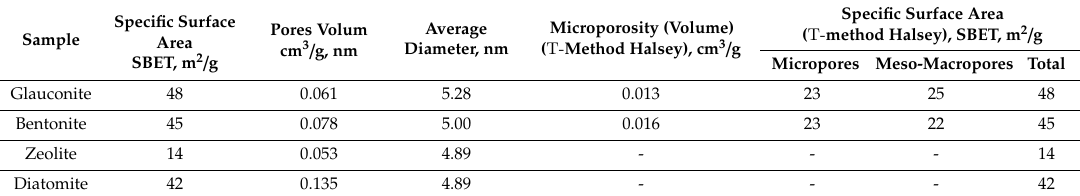
Table 3. Textural properties of studied mineral